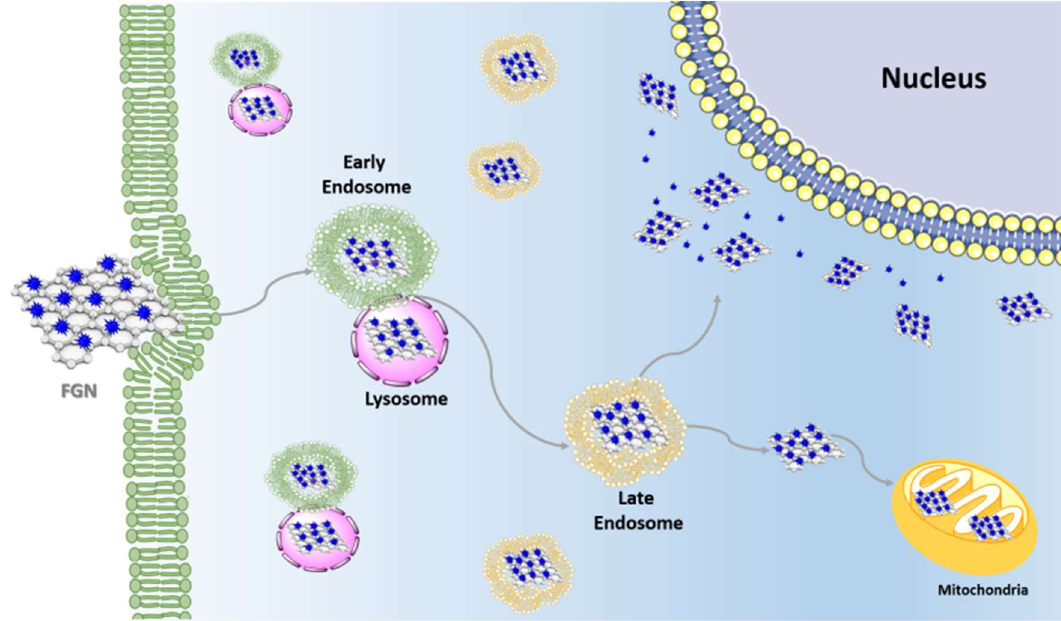
Figure 3. The schematic representation of intracellular transportation and the entrapment of Functional Graphene Nanomaterials (FGN) by endosome/lysosome system.